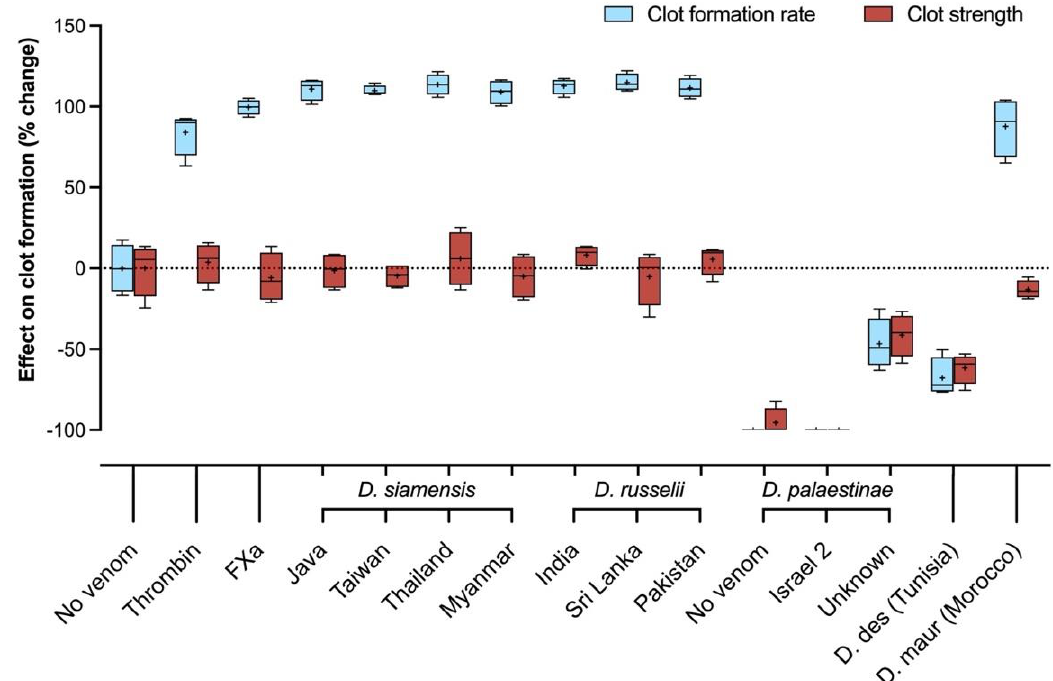
Figure 5. Thromboelastography of human plasma incubated with 20 µ g/mL venoms of Daboia . A total of 20 uL/mL of thrombin and FXa were used as positive controls. Angle (degrees; pale blue, left y-axis) represents the rapidity of clot formation as a combined measure of enzymatic activity and fibrinogen function; maximum amplitude (mm; dark red, right y-axis) represents clot strength, where higher amplitude denotes greater strength. The assay runs for 30 min at 37 ◦ C. Box plots depict median (line), mean (+), and range (error bars) of four independent replicates; D. des = D. deserti , D. maur = D. mauritanica .